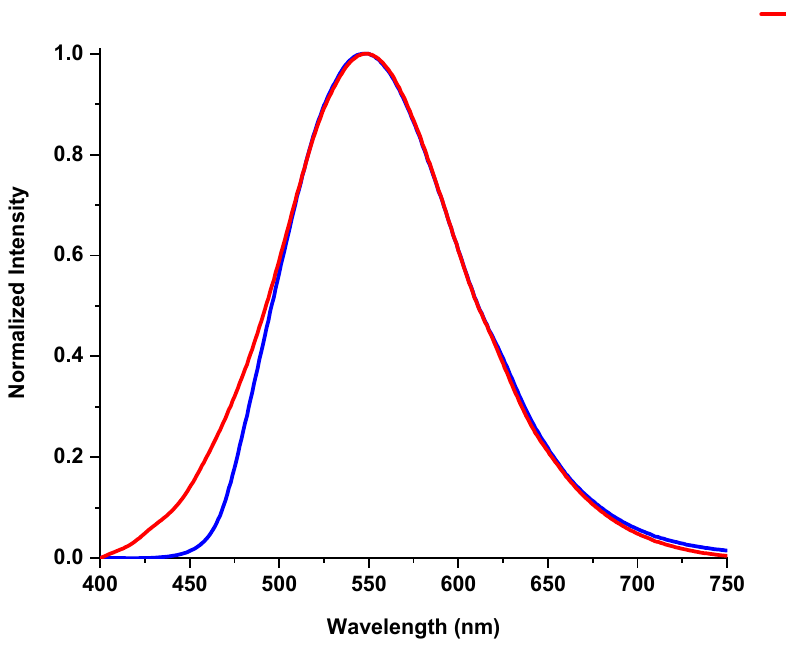
Figure 27. Normalized emission spectra of polymers 3 a,b in the solid state. Excitation at 375 nm.